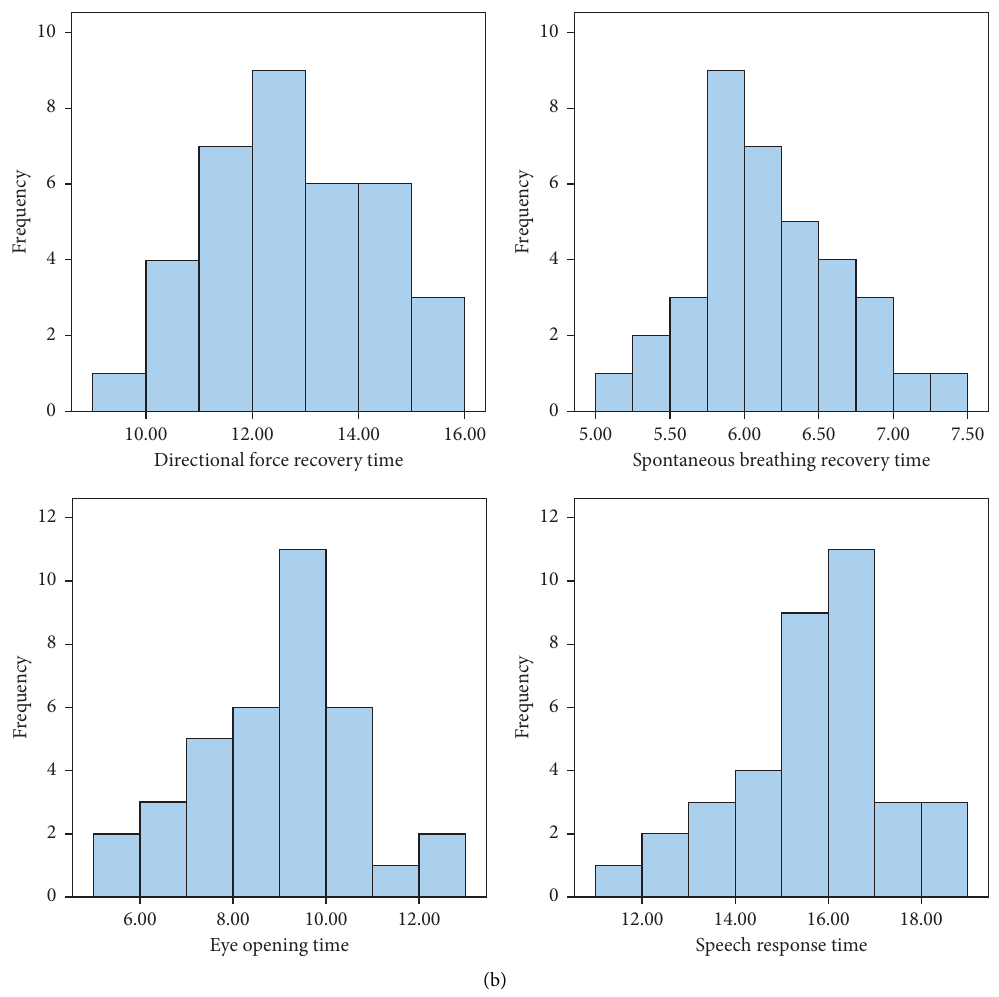
Figure 1: Level distribution of indexes related to the anesthesia efect in two groups (Note. (a) Level distribution of indexes related to anesthesia efect in the control group; (b) Level distribution of indexes related to anesthesia efect in the observation